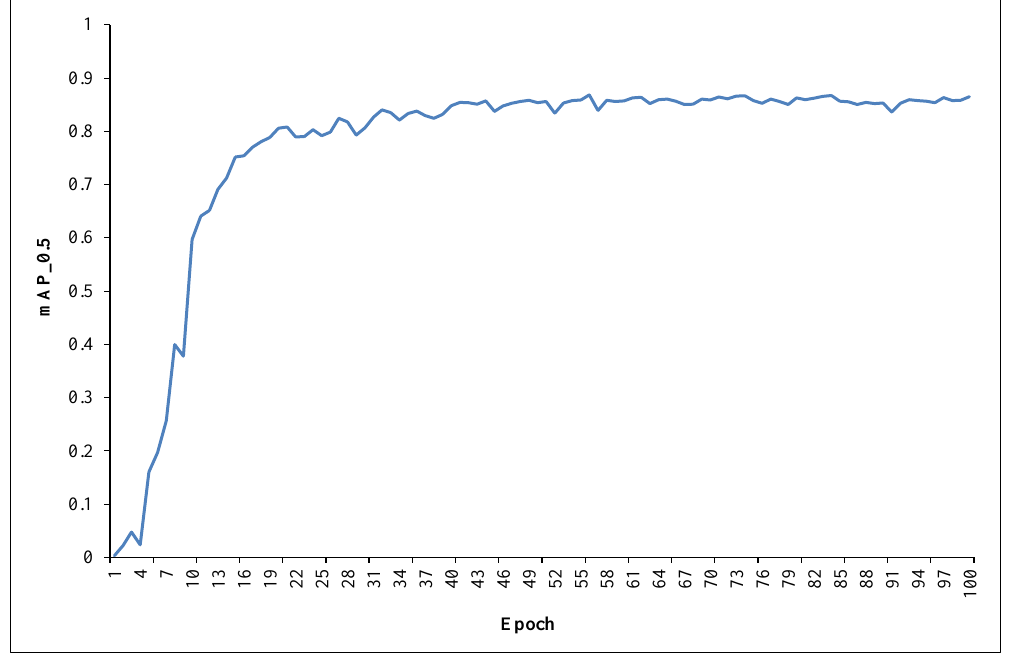
Figure 4. Yolov5s model mAP_0.5 vs